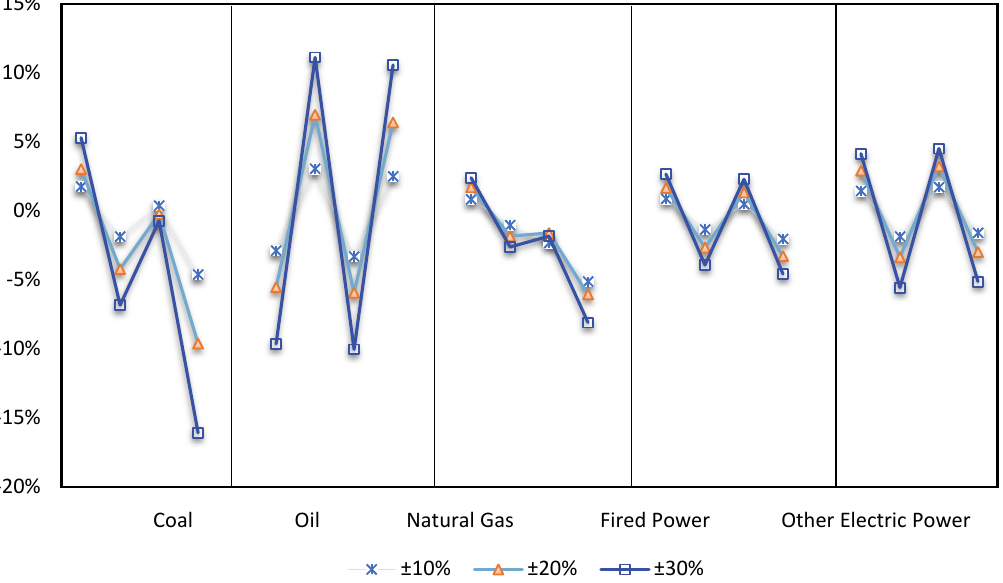
Figure 4. Impact of different scenarios on energy demand and structure Unit: %.